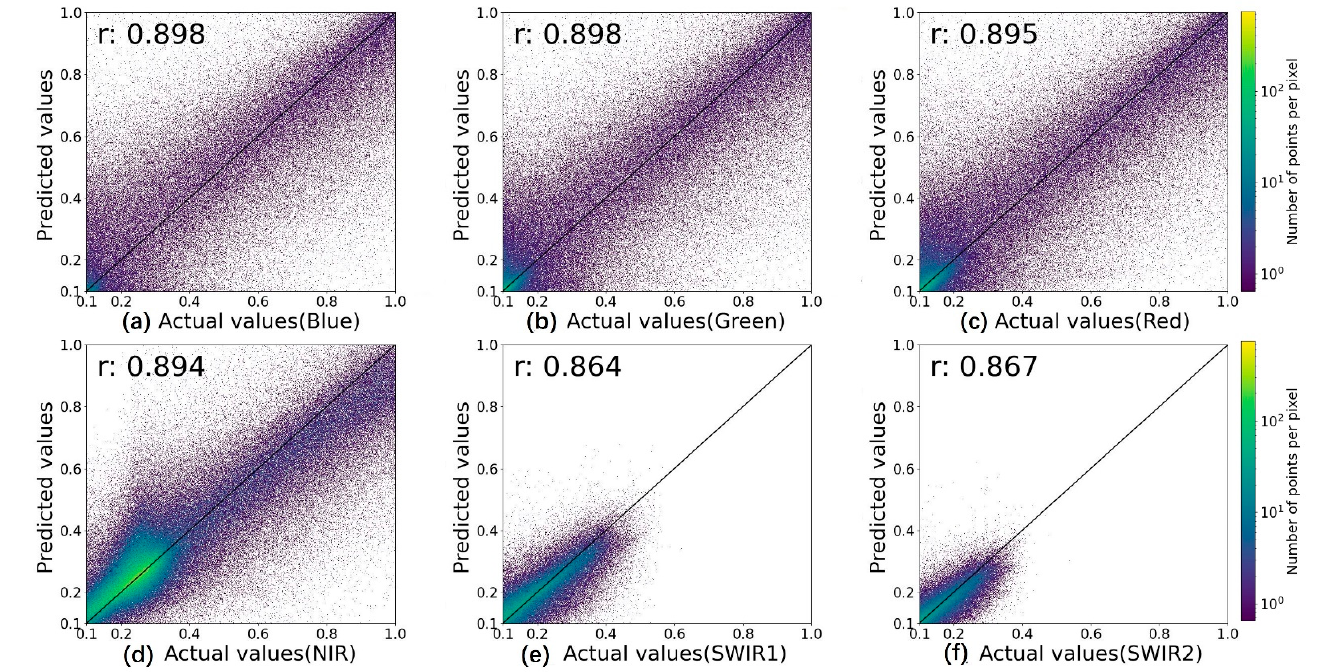
Figure 9. Scatter plots of the actual and predicted values for the six bands of ESTARFM. (( a – f ) for different bands and the dark line is a 1:1 line).